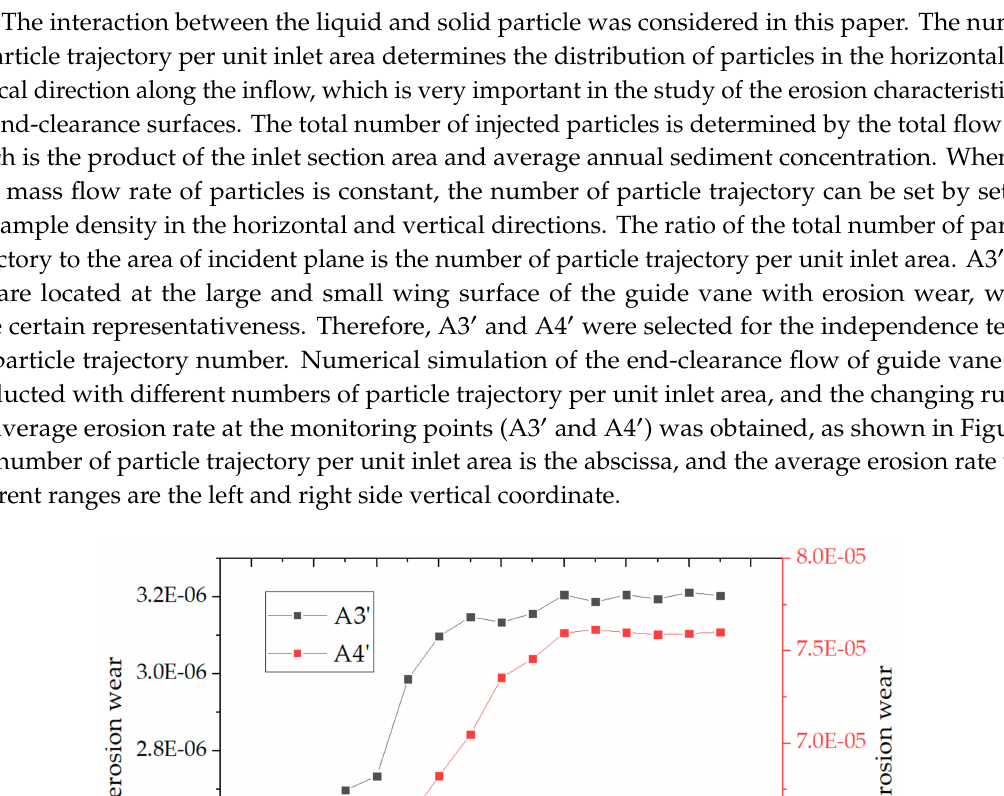
Figure 8. Arrangement of the monitoring points.